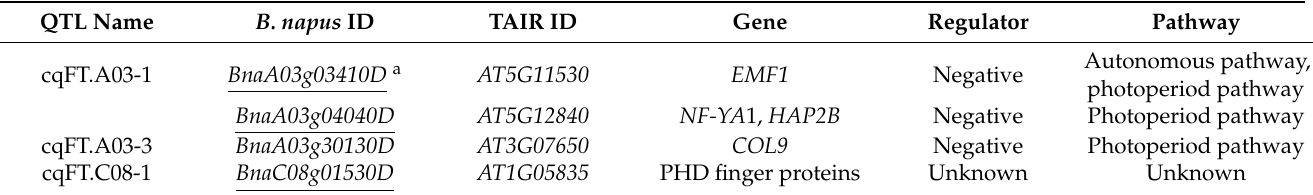
Figure 4. Bubble chart of top 20 Kyoto Encyclopedia of Genes and Genomes (KEGG) pathways with significant enrichment of 11,888 DEGs. Rich factor indicates degree of enrichment. Redder q -value color indicates a greater significant difference, and bubble size indicates number of DEGs. Table 3. Information on flowering time genes in QTL